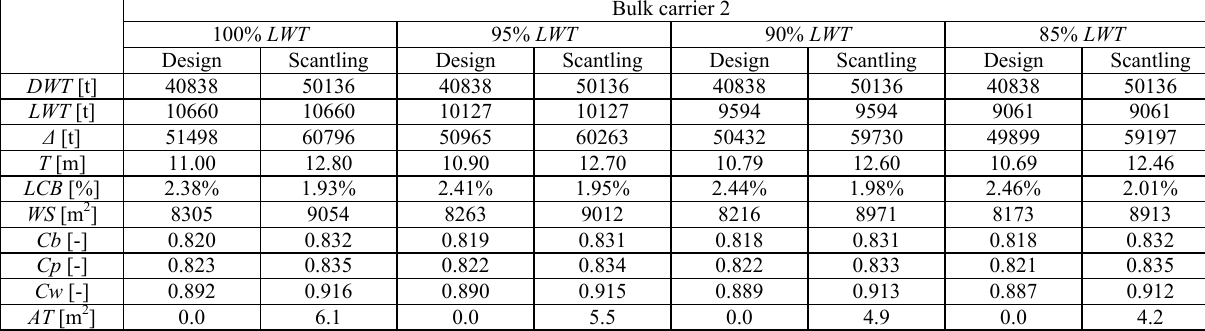
Table 11. Input parameters for HM method (bulk carrier